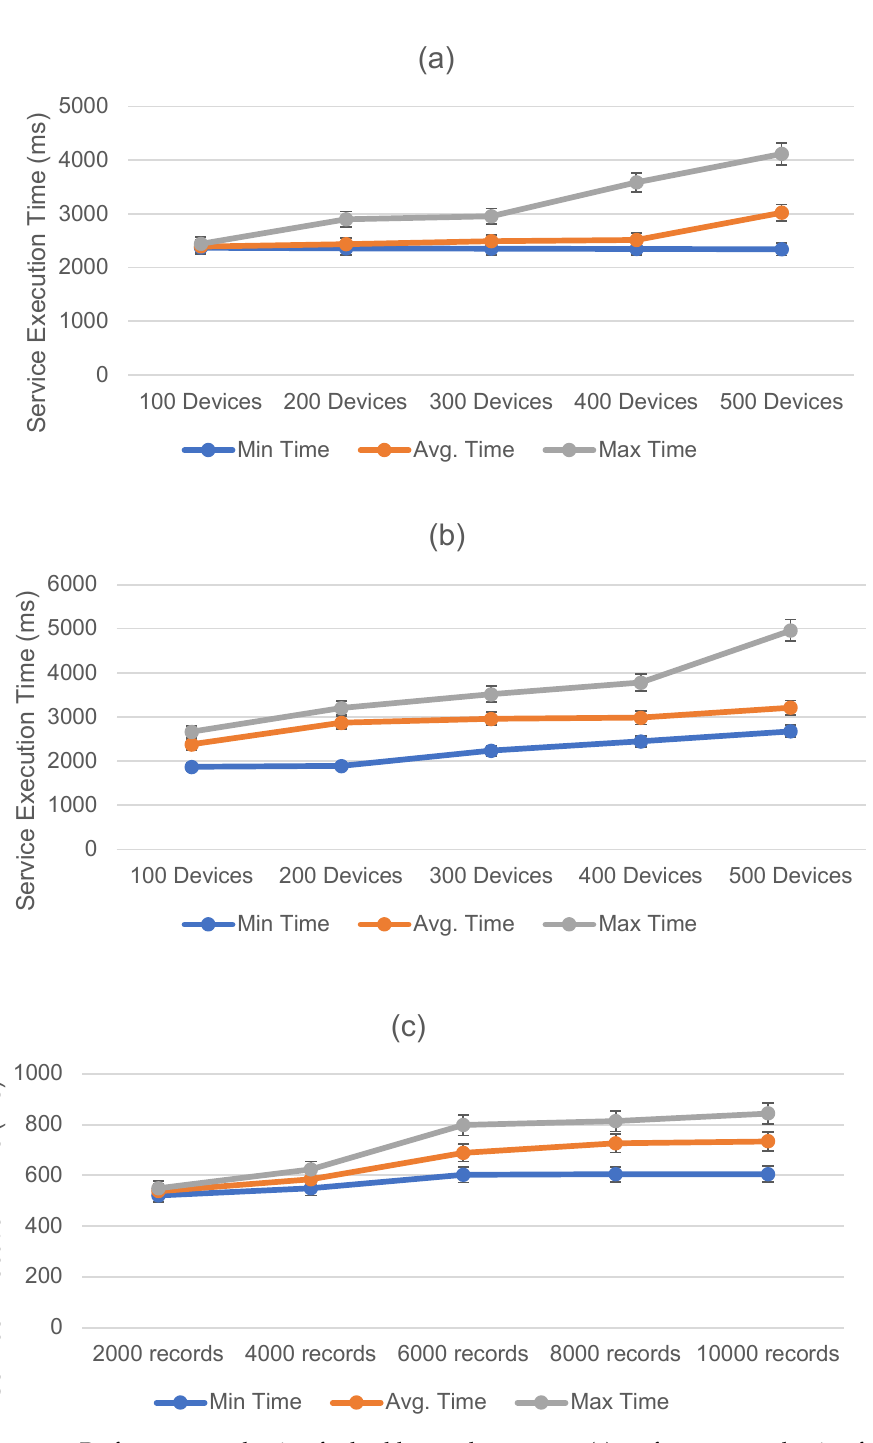
Figure 10. Performance evaluation for health care department: ( a ) performance evaluation for device creation; ( b ) performance evaluation for sensor reading; ( c ) performance evaluation for query